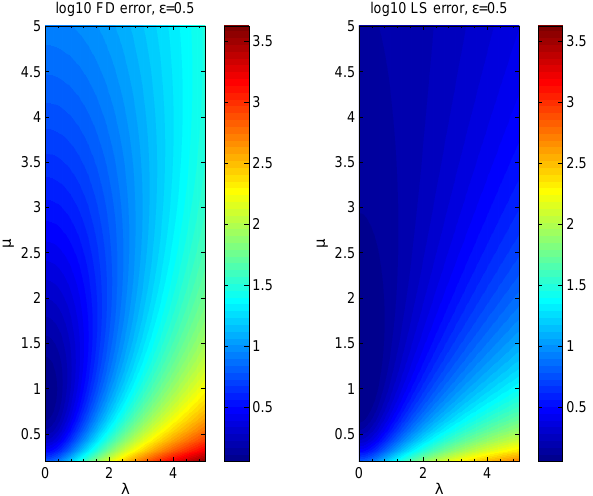
Fig. 3. Logarithm of the normalised error amplification factor ( P σ | q σ | 2 ) · ( P σ | r σ | 2 )/ 4 of the least squares planar (LS) gradient estimator in terms of λ = ‘/L and µ = M/L for ε = 0 . 01.